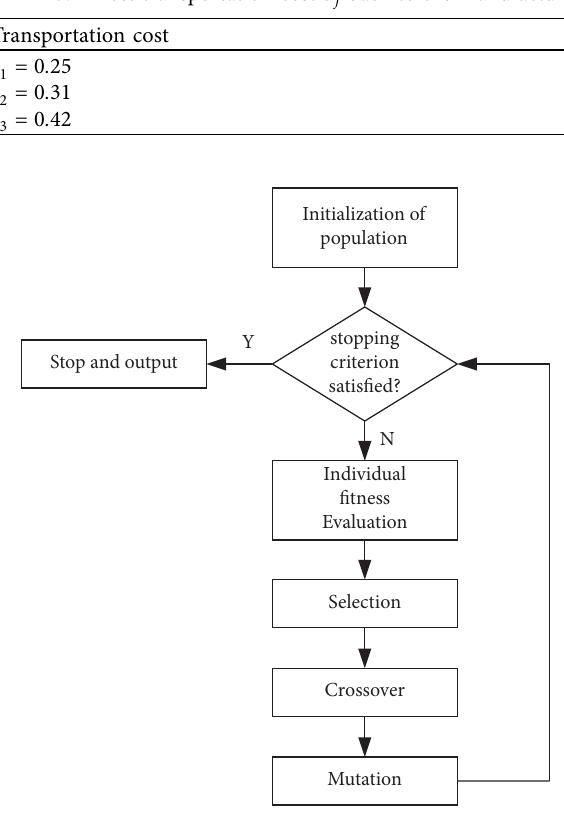
Table 5: Direct transportation cost e